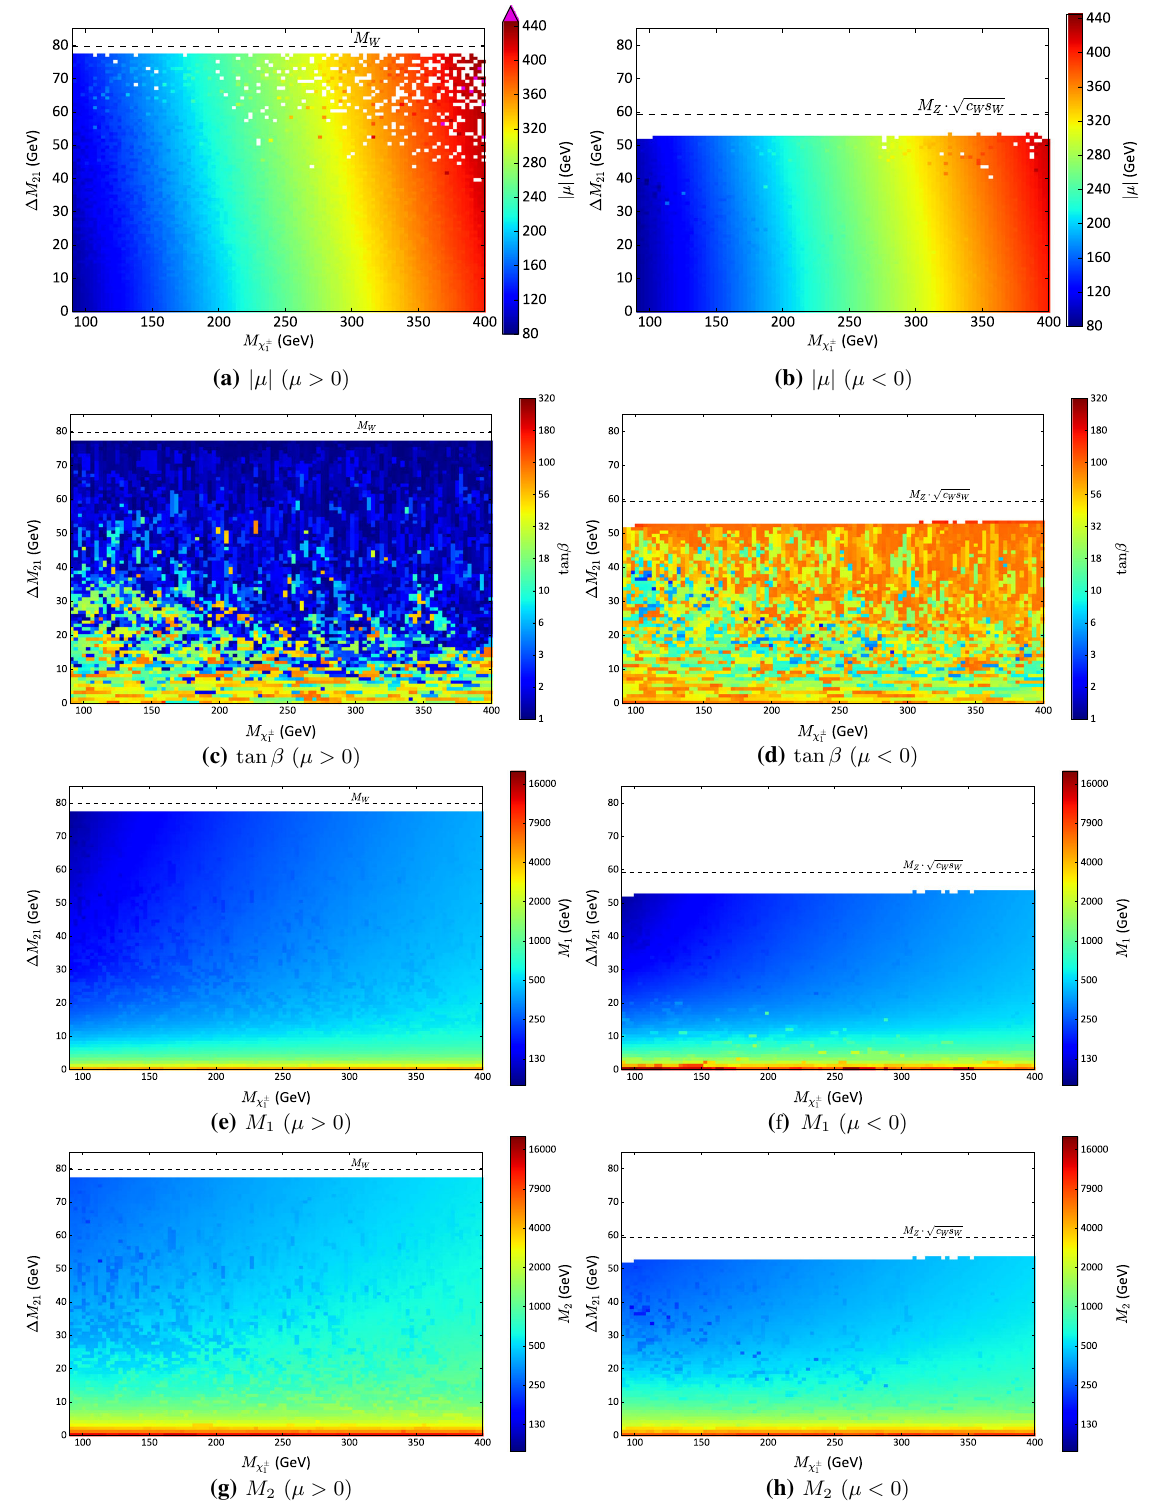
Fig. 5 Fitted MSSM parameters | μ | ( a , b ), tan β ( c , d ), M 1 ( e , f ) and M 2 ( g , h ) for μ > 0 and μ < 0, respectively. Due to the limited sen- sitivity of the fit, the last three are shown logarithmically. Chargino